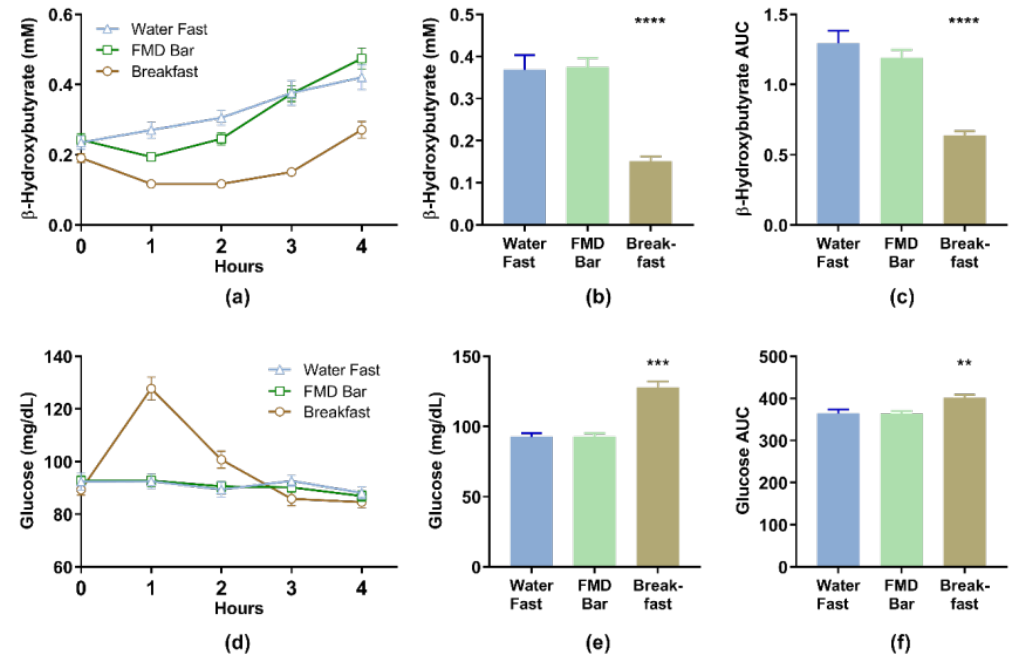
Figure 2. After 15 h of overnight fast, study foods were consumed at hour 0 for the breakfast and FMD groups. ( a ) Ketone and ( d ) glucose levels were measured at time 0 and hourly for 4 h. ( b ) Blood ketone levels 3 h after the experimental groups consumed the study foods. ( c ) Ketone and ( f ) glucose area under the curve (AUC) between hour 0 and 4 after the experi- mental groups consuming the study foods. ( e ) Blood glucose levels 1 h after the experimental groups consuming the study foods. Data represent mean and standard error. ** p < 0.01, *** p < 0.001, **** p < 0.0001, FMD or breakfast group compared to the water fast group, one way ANOVA, with Tukey’s multiple comparisons test.